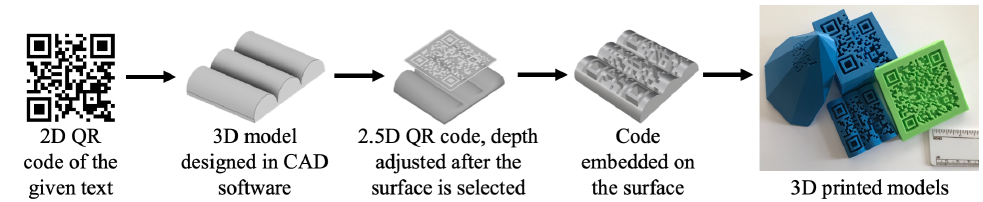
Figure 2. Design and manufacturing pipeline for embedding QR codes on the